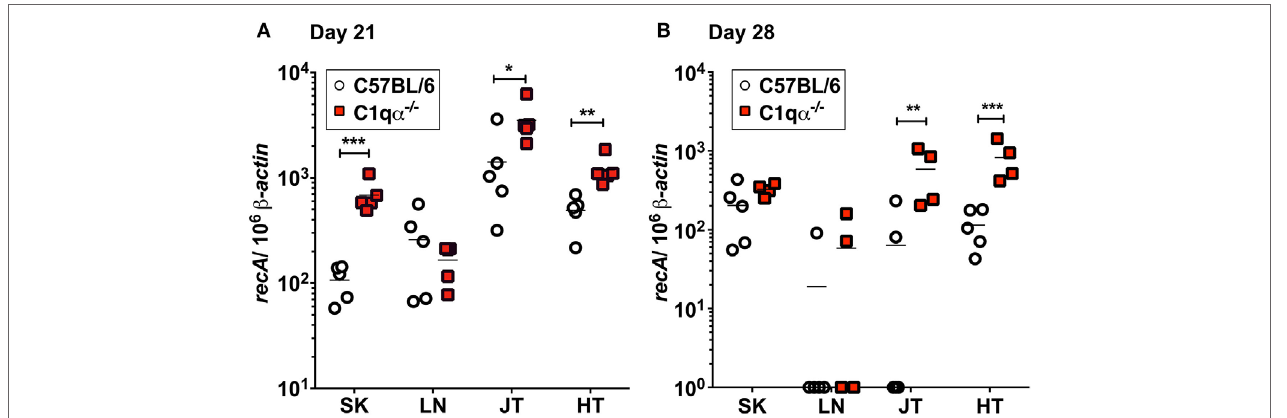
FigUre 1 | Quantitative PCR of infectious Borrelia burgdorferi in the parent C57BL/6 mice versus mice lacking the complement protein C1q (C1q α − / − ). Mice were infected with 10 4 B. burgdorferi strain MSK5 (24) for (a) 21 days and (B) 28 days and total DNA isolated from skin (SK), lymph node (LN), joints (JT), and heart (HT). The white circles refer to the parent C57BL/6 mouse background samples whereas the red squares indicate the values determined from the C1q α − / − knockout mouse tissues samples ( n = 4 or 5). The results are represented as the number of borrelial genome copies per 10 6 mouse β -actin copies (* P < 0.05; ** P < 0.01; and *** P <